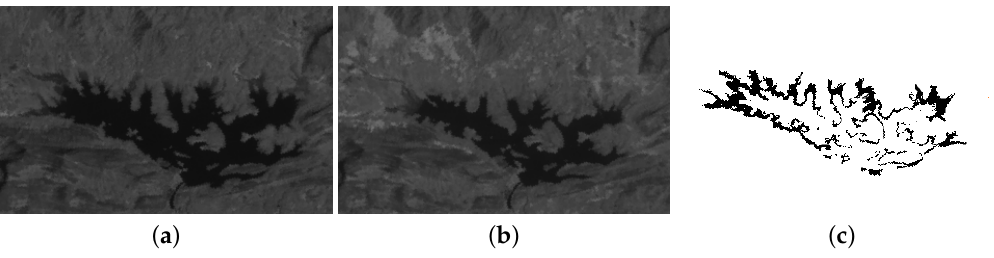
Figure 4. Band 2 of the multitemporal images of Malambuzha Reservoir, Kerala, India ( a ) acquired on 14 January 2001, ( b ) acquired on 18 February 2002, and ( c ) Reference Change